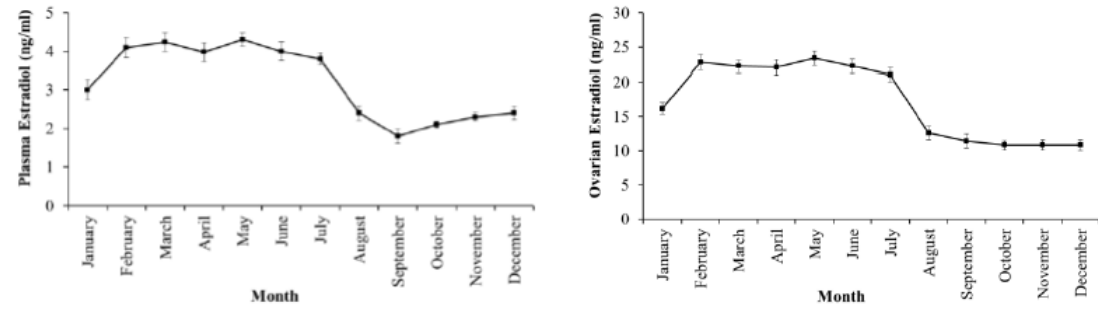
Figure 6. Monthly change in estradiol level in plasma ( left ) and ovarian ( right ) of the wild-caught blue tang fish (n the same as Figure 2a).